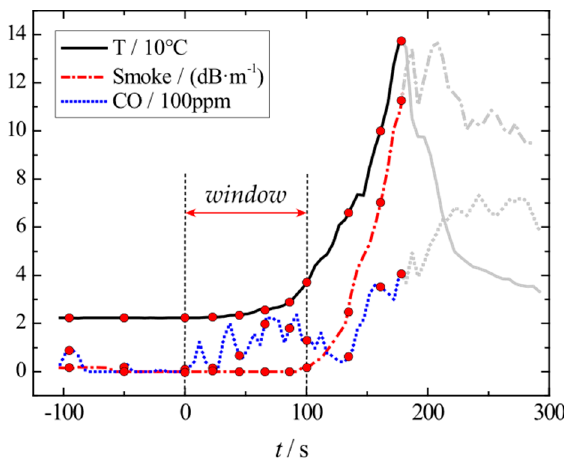
Figure 3. Non-uniform